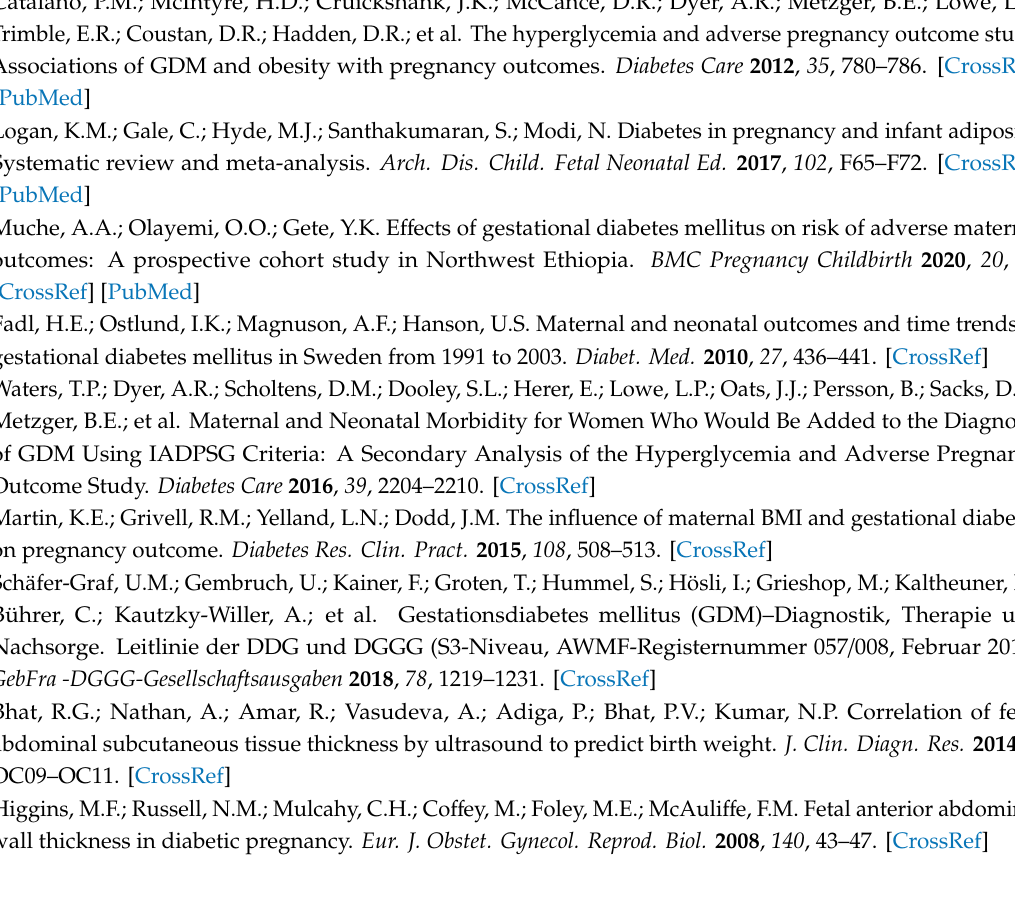
Figure S1: Scatter plots showing retrieved values of estimated fetal